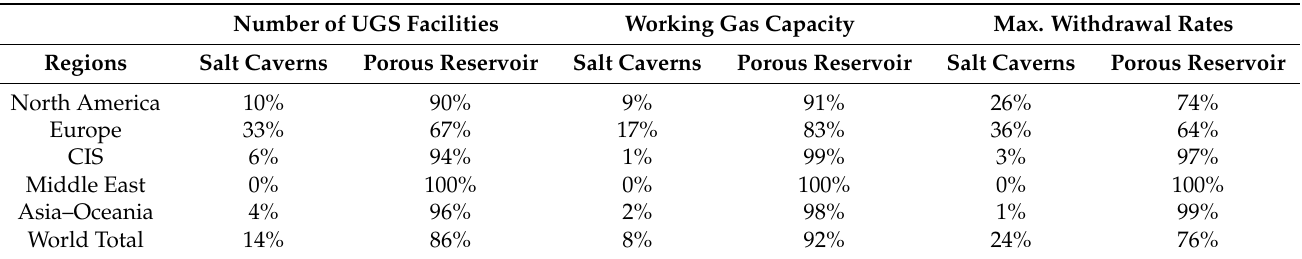
Table 2. The percentage of the depleted oil and gas reservoir type of UGS in the total number of UGSs (modified from Cedigaz